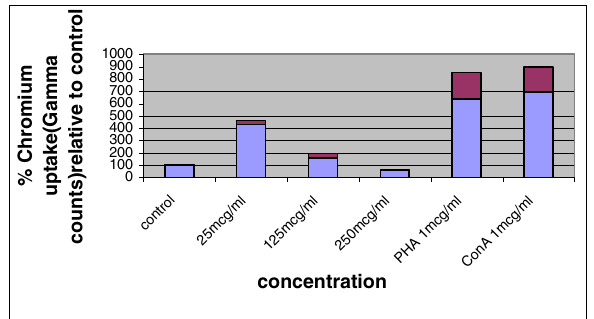
Figure 1 T cell mitogenicity in the presence of GFS whole extract in vitro . GFS extract assessed at 25, 125, 250 micrograms/ml (as1%, 5% and 10% of culture medium from a stock solution at 2.5 mg/ml). PHA and ConA were assessed at 1 mcg/ml. N = 3 in all cases. Blue bars indicate average readings, red bars indicate standard